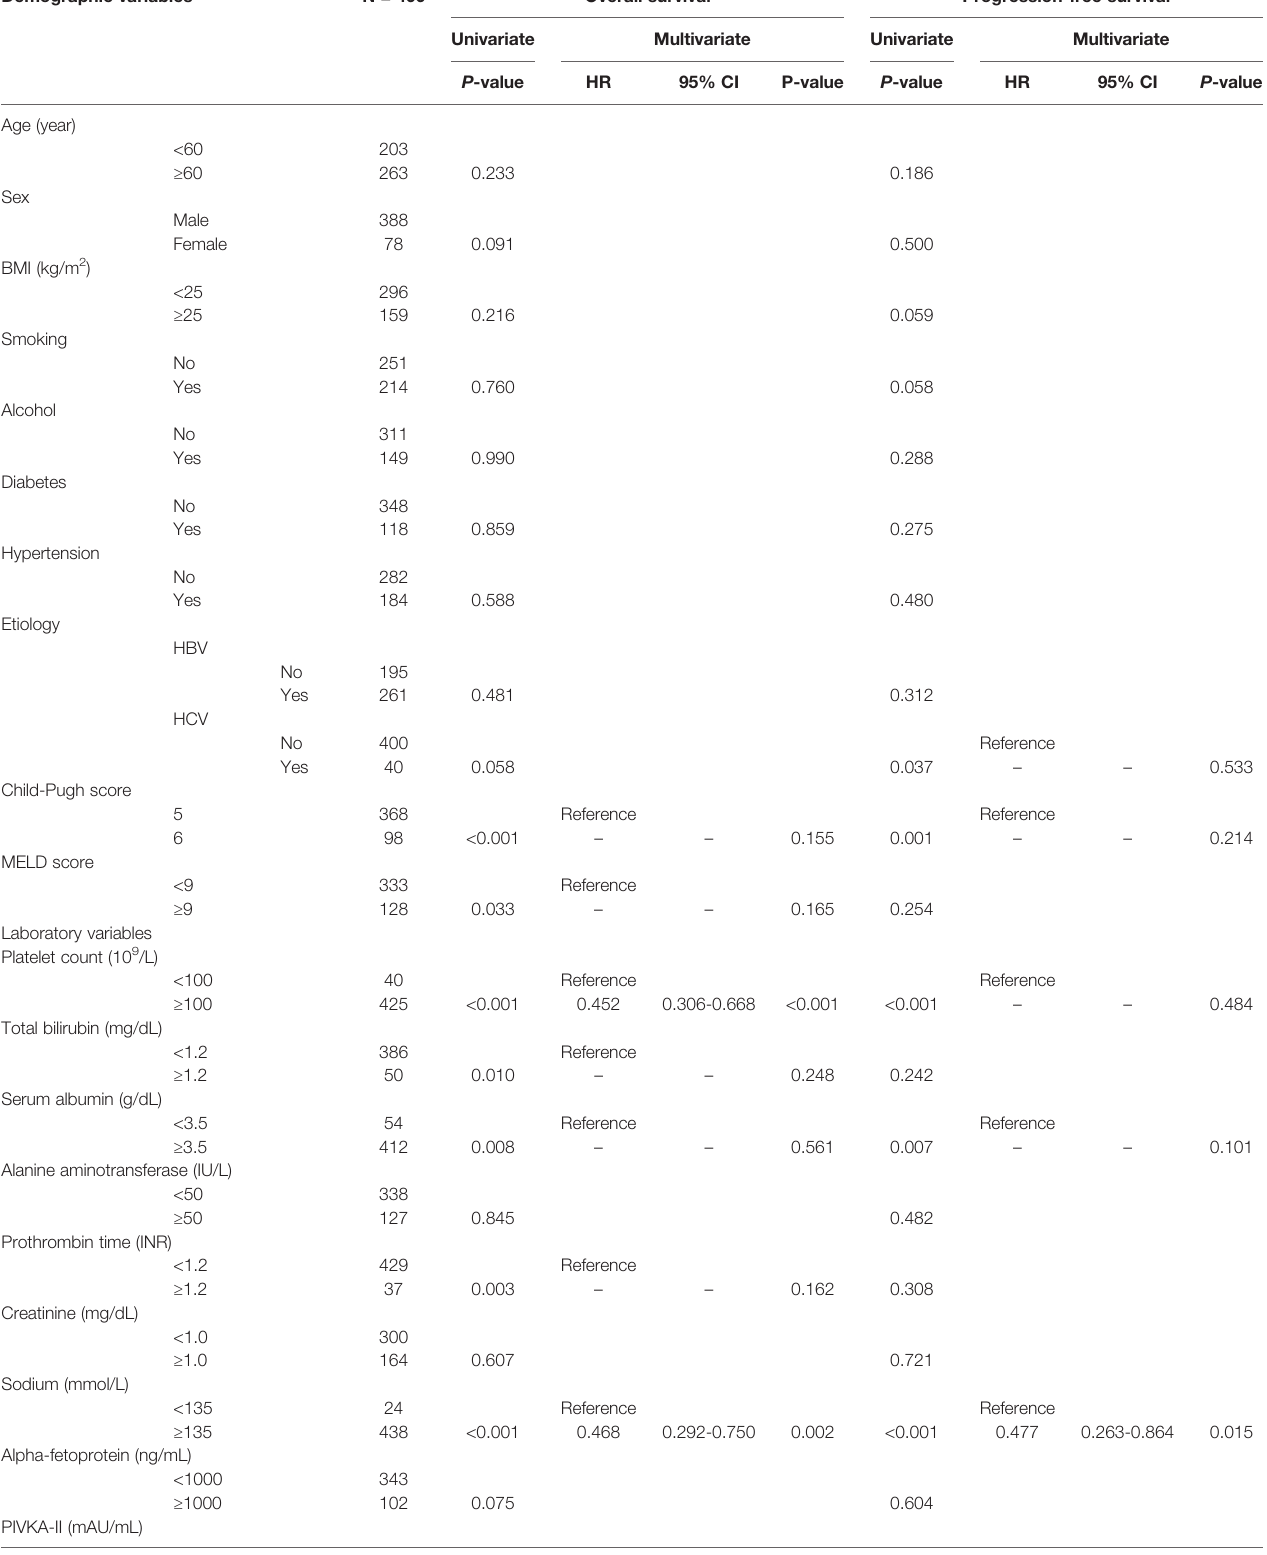
TABLE 2 | Univariate and multivariate analyses of factors affecting overall survival and progression-free